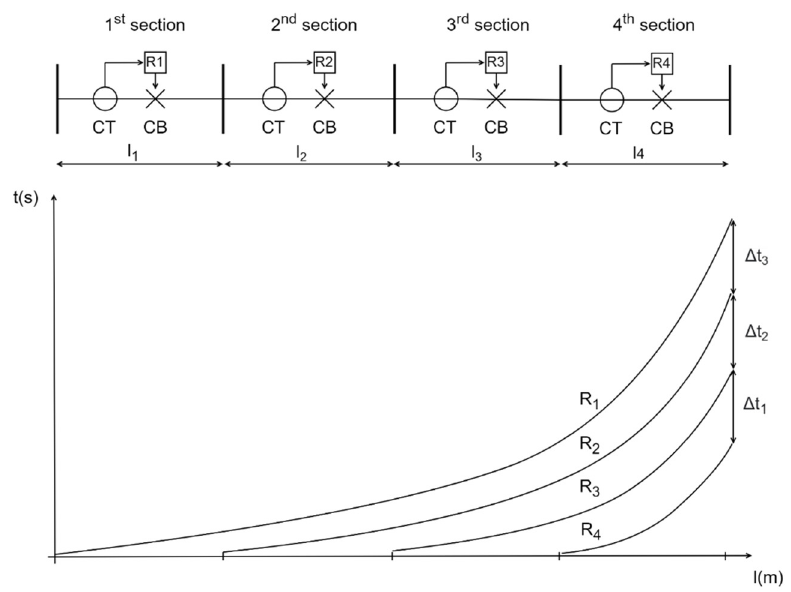
Figure 5. An example of the proper inverse-time OCR operation optimization for a radial distribution network.